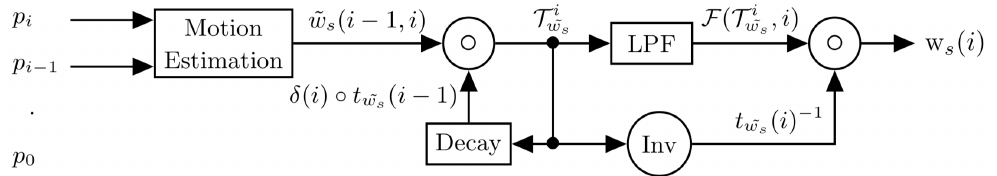
Figure 3. Typical stabilization procedure. “Inv” corresponds to an inversion in the space of warping transforms; LPF stands for low-pass